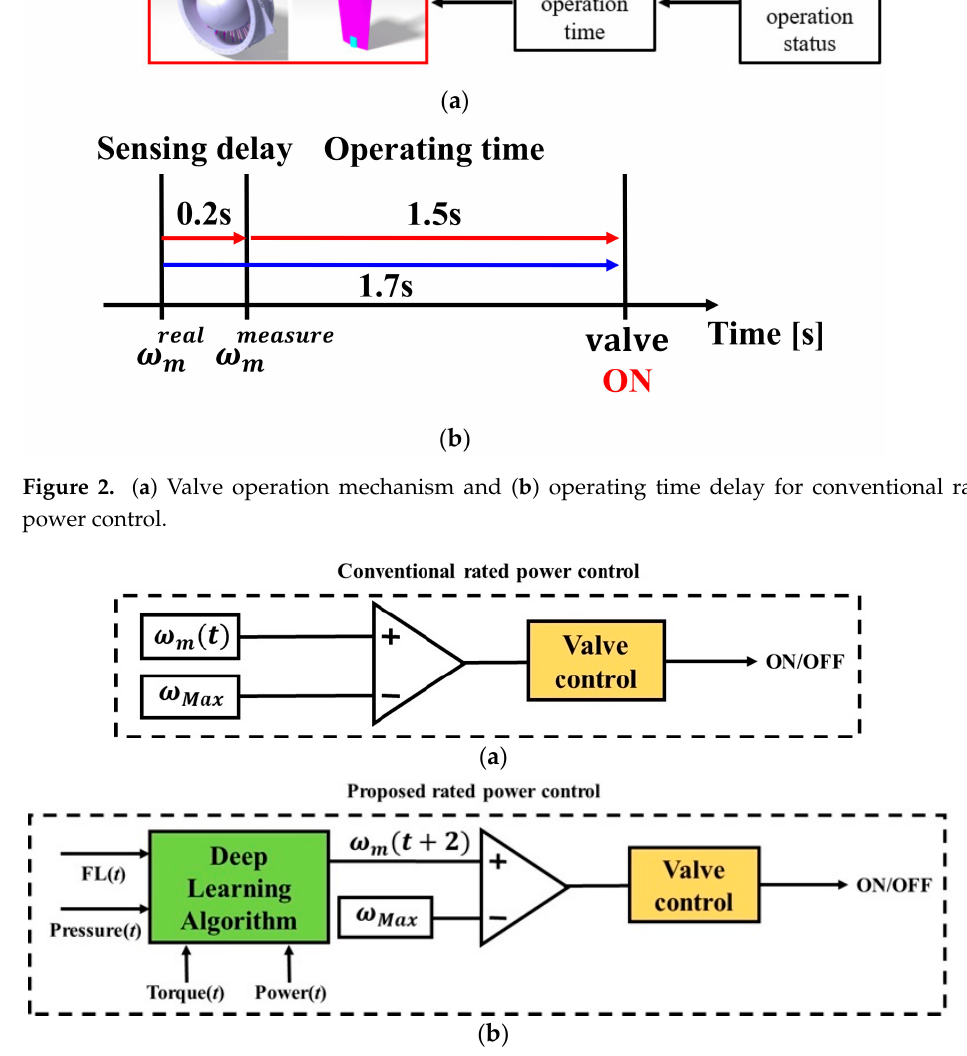
Figure 3. ( a ) Conventional valve control method and ( b ) proposed valve control method for rated power control. power